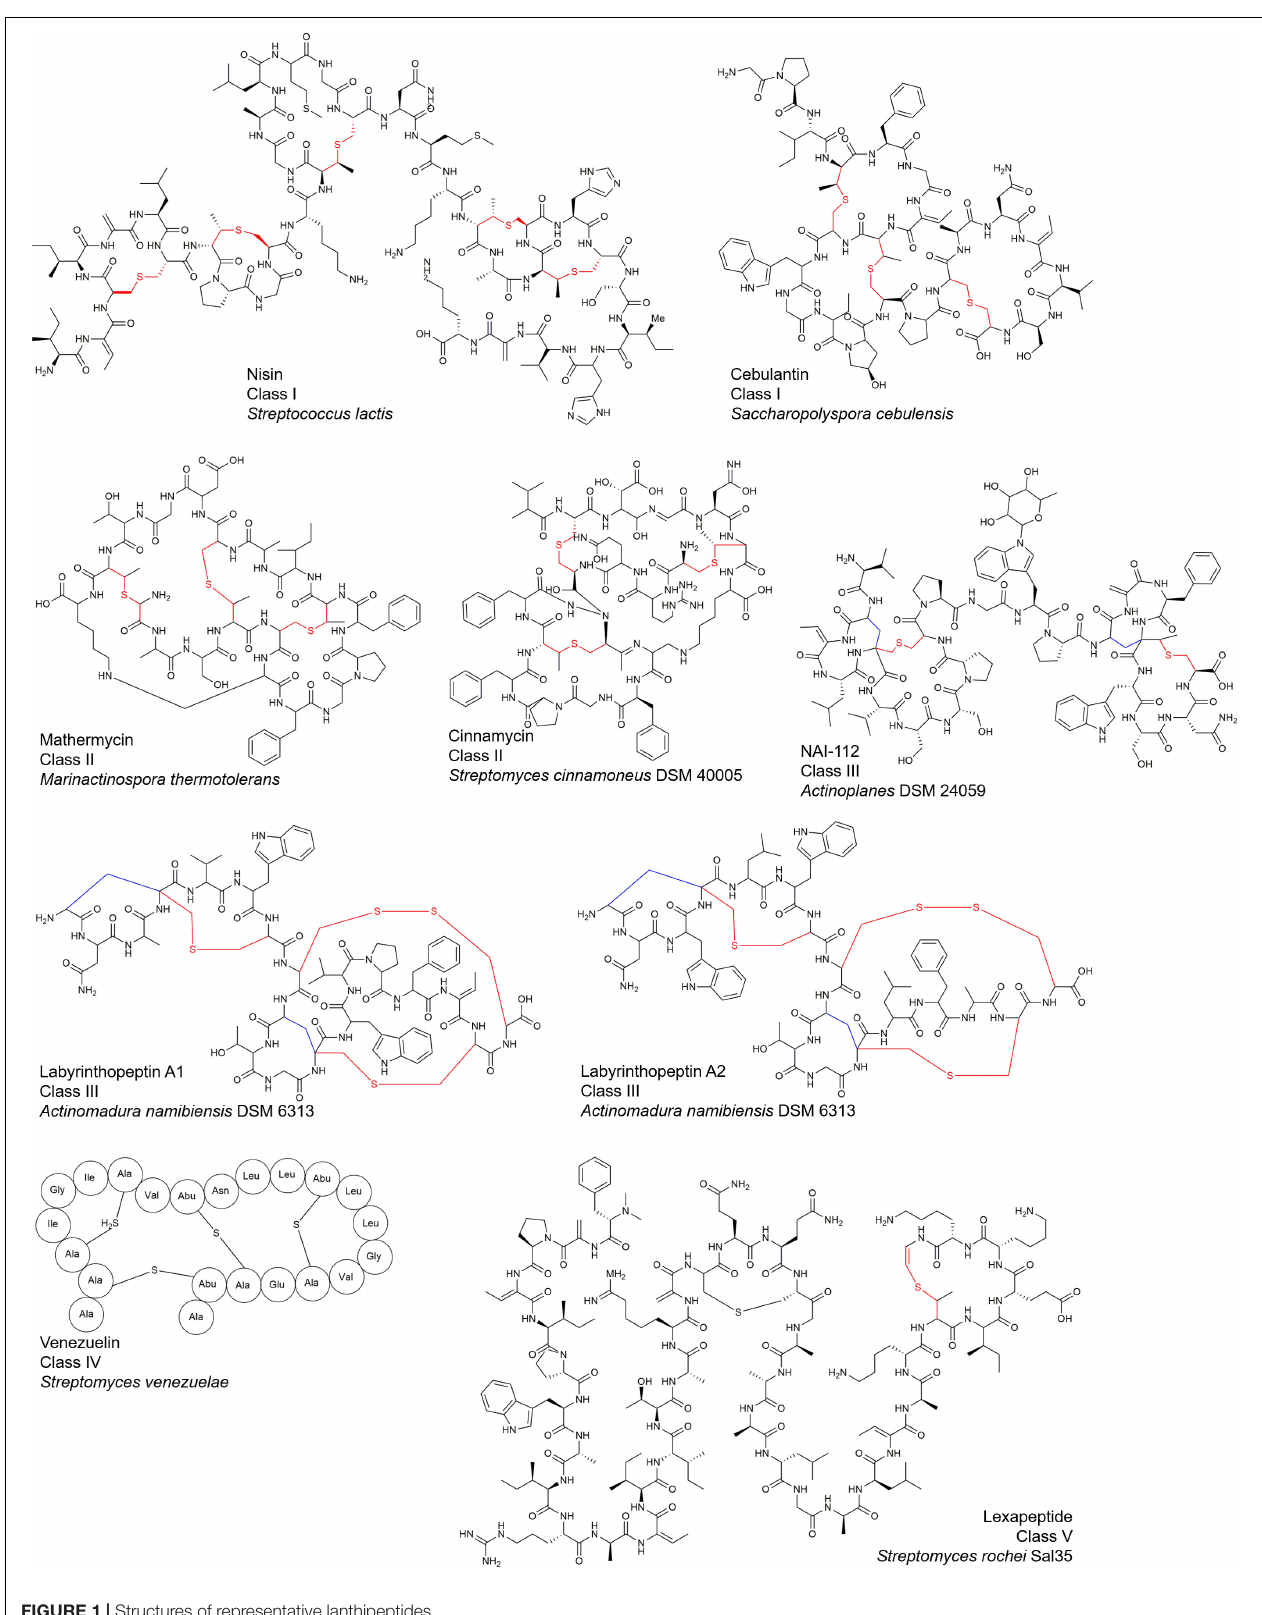
Frontiers in Bioengineering and Biotechnology |